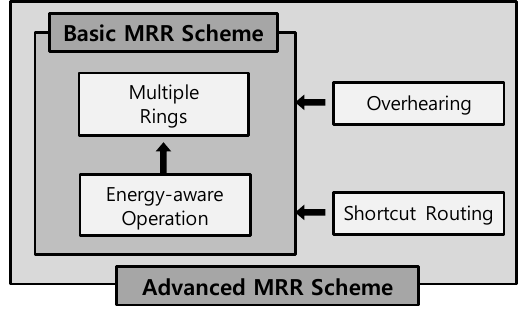
Figure 2. Sub-methods composing MRR